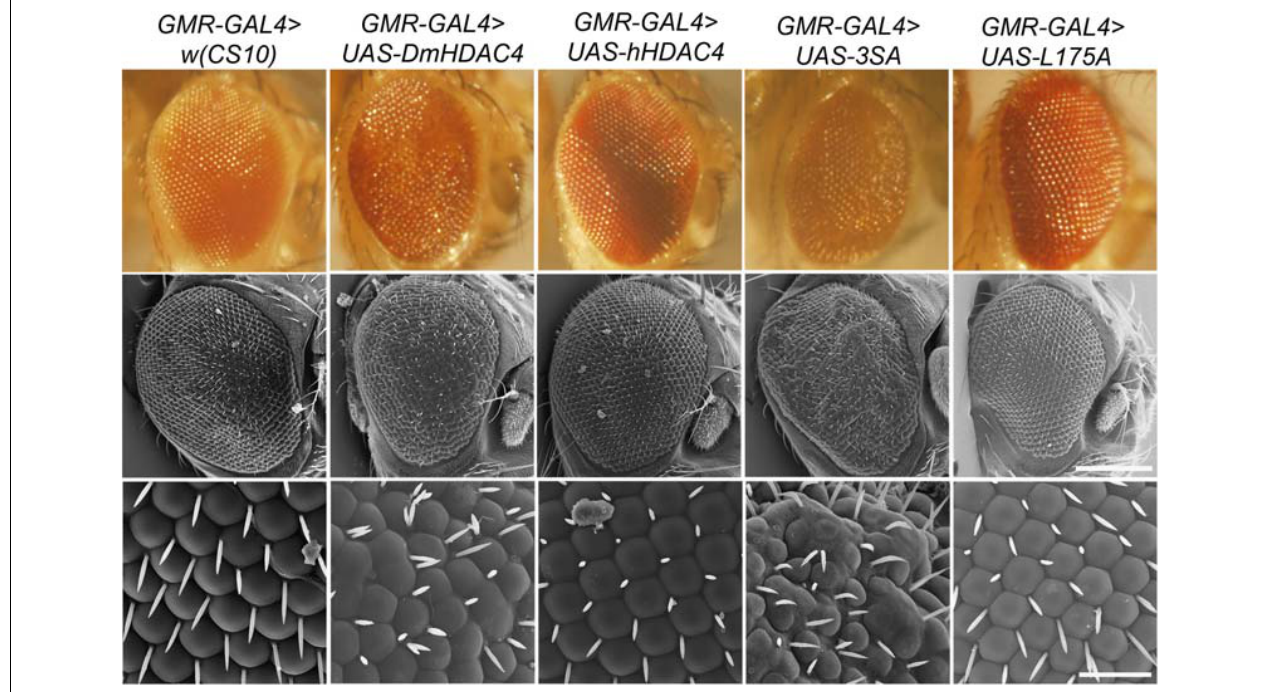
FIGURE 3 | Nuclear accumulation of HDAC4 disrupts eye development. Stereomicrographs and scanning electron micrographs (SEM) of Drosophila eyes expressing FLAG-tagged HDAC4 variants. The indicated genotypes were generated by crossing GMR-GAL4 females to males carrying each UAS-HDAC4 transgene and to the w(CS10) control. Top panel: Stereomicrographs, 110 × magnification. Middle panel: SEM, 250 × magnification. Scale bar = 200 µ m. Lower Panel: SEM, 1,500 × magnification. Scale bar = 30 µ